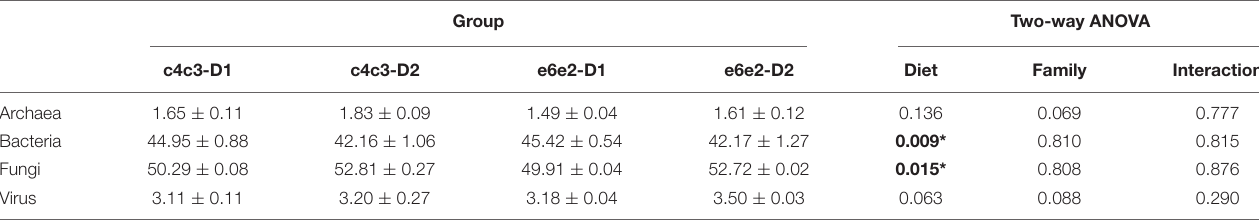
expression values in e6e2-D2 and c4c3; C2, 1,007 genes down- regulated in e6e2 fish in comparison to c4c3 fish; C3, 1,502 genes down-regulated in e6e2-D1 with higher expression